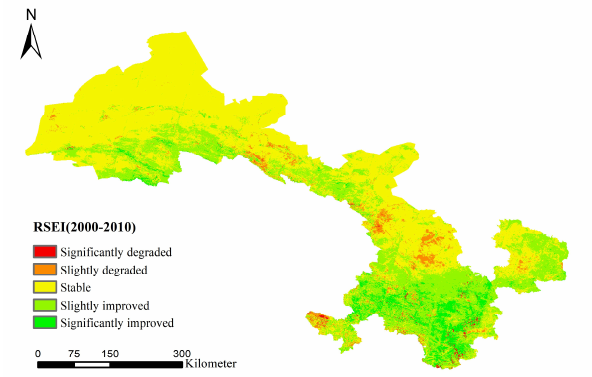
Figure 6 . Changes in ecological quality from 2000 to 2010.